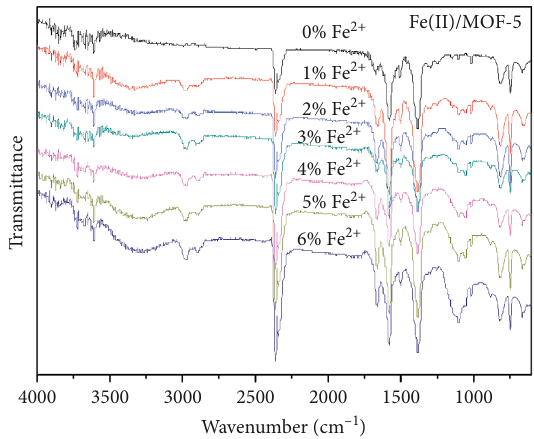
Figure 2: IR spectra of Fe